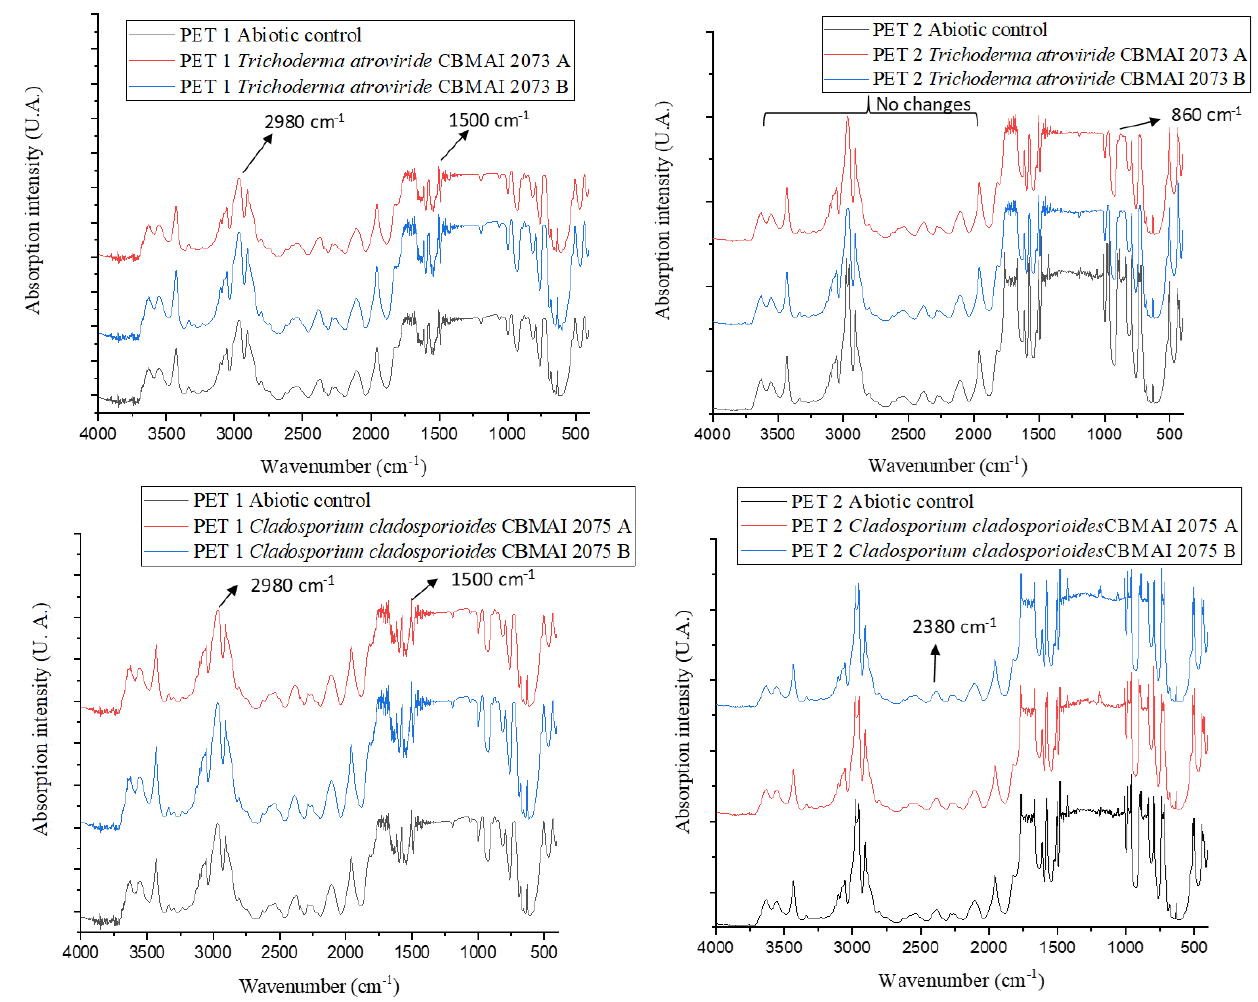
Figure 7. PTA, BHET, and MHET concentrations released from PET1 and PET2 with three different